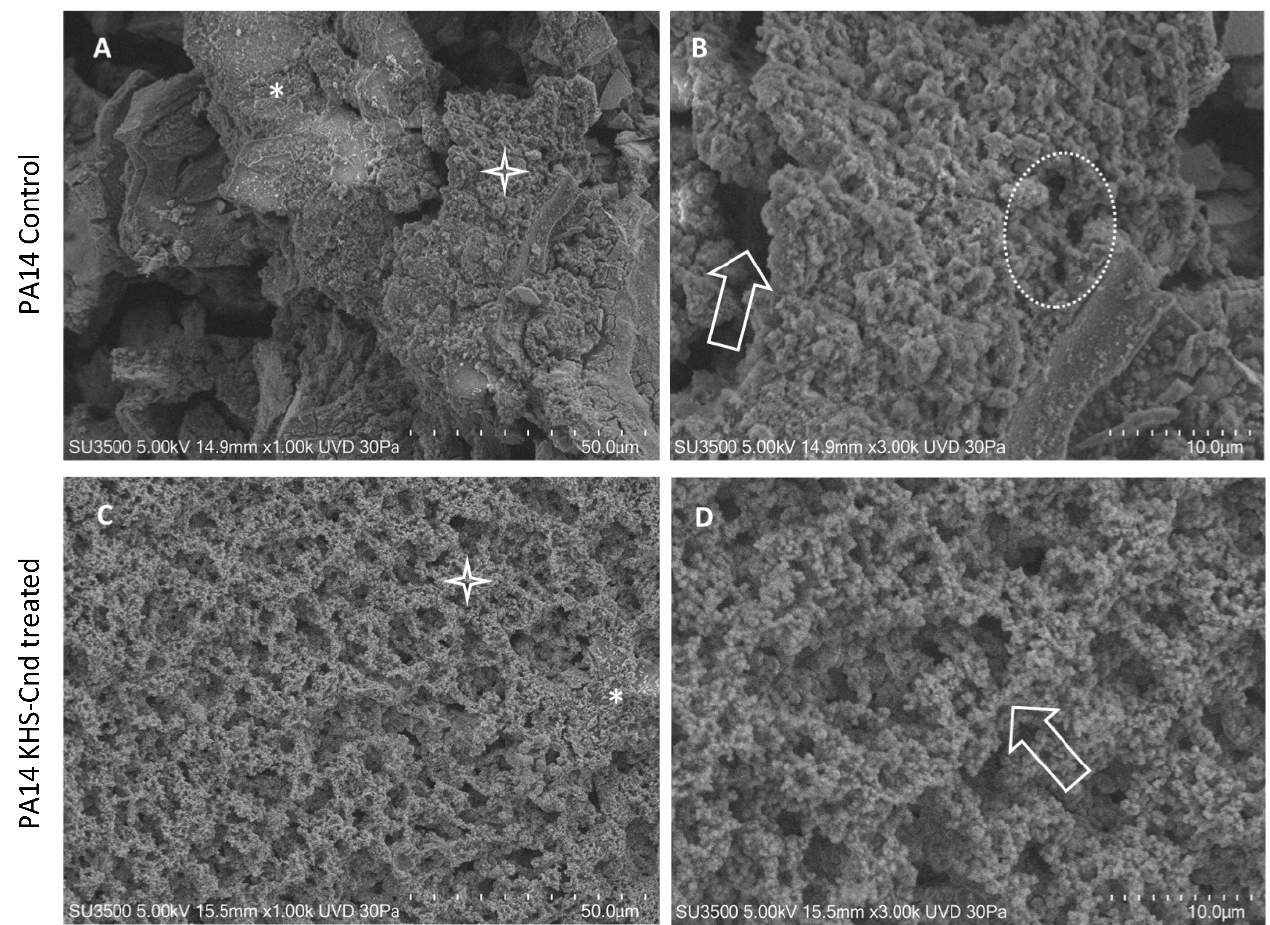
Figure 2. VP-SEM images of untreated P. aeruginosa PA14 ( A , B ). ( A ) Low magnification (1.00 K) showed smooth and compact ECM areas (asterisk), spongy, and rough areas (star). ( B ) At higher magnification (3.00K), ECM showed large meshes in some areas (arrow) and smaller ones in others (dotted oval). VP-SEM of P. aeruginosa PA14 treated with KHS-Cnd ( C , D ). ( C ) At low magnification (1.00 K), ECM appeared almost totally with a spongy appearance (star), and rare compact areas (asterisk) were present. ( D ) Higher magnification (3.00 K) showed that a 3D network of ECM trabeculae was formed by the aggregates of fine granular filaments having a “pearl necklace” aspect (arrow). Comparing the images in false colors of the control sample (Figure 3A,B) with the images of the treated sample (Figure 3C,D), the disaggregating effect of KHS-Cnd was evident: the trabeculae in the control sample presented an arrangement with tighter filaments, and the meshes were tight, while the trabeculae in the treated sample had a loose filament arrangement and the meshes were larger. Images of untreated P. aeruginosa 27P samples in Figure 4A showed the presence of an abundant extracellular matrix (ECM), organized in both compact (asterisk) and spongy (star) areas. The observation at higher magnification (B) of the spongy area showed in more detail that ECM was formed by interconnected laminae, rather than trabeculae (as in PA14) with curly edges (l, laminae). The 3D arrangement of interconnected laminae formed a labyrinthic system of channels (larger than that of PA14), producing an ECM spongy